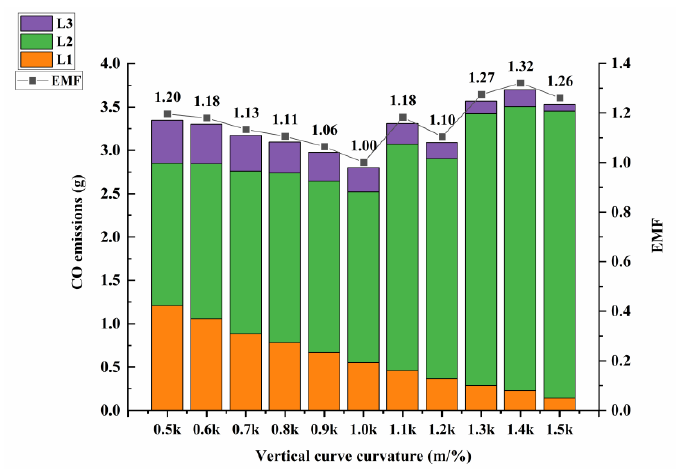
Figure 4. Relationship between CO emissions and curvature.